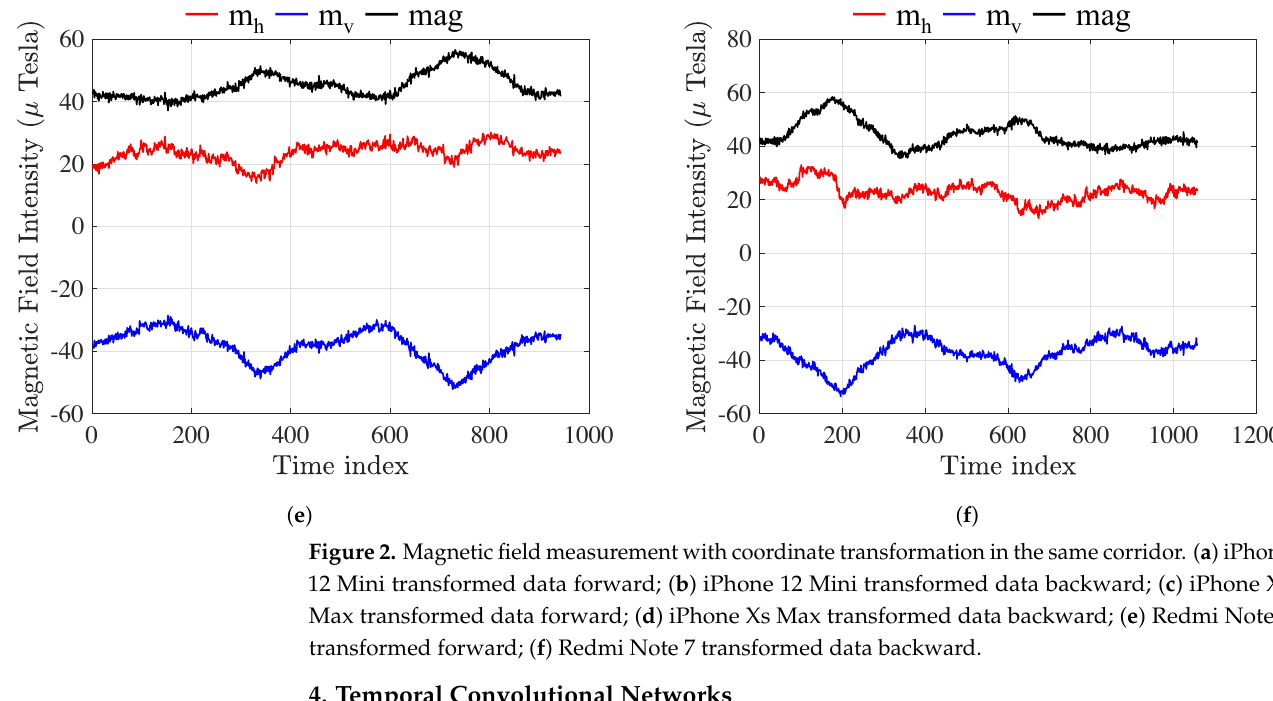
Figure 2. Magnetic field measurement with coordinate transformation in the same corridor. ( a ) iPhone 12 Mini transformed data forward; ( b ) iPhone 12 Mini transformed data backward; ( c ) iPhone Xs Max transformed data forward; ( d ) iPhone Xs Max transformed data backward; ( e ) Redmi Note 7 transformed forward; ( f ) Redmi Note 7 transformed data